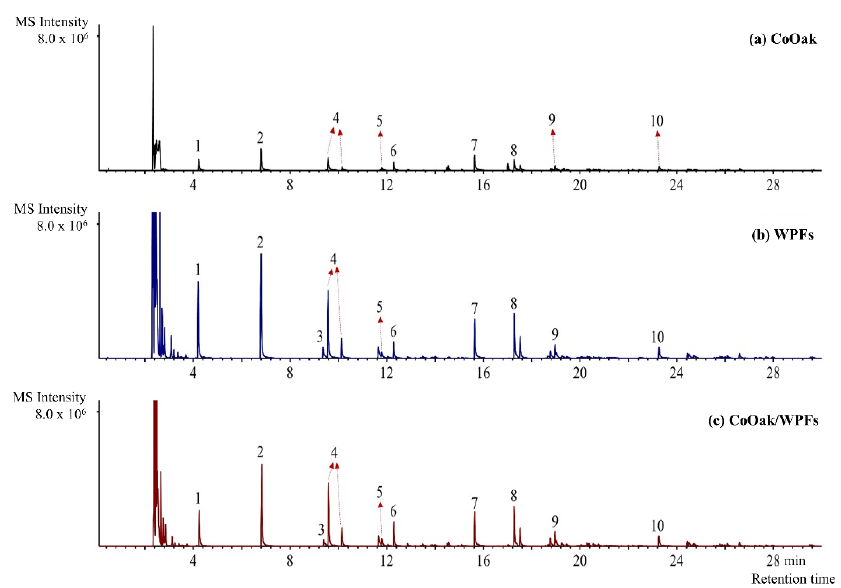
Figure 3. Pyrograms obtained from catalytic pyrolysis of ( a ) Cork Oak; ( b ) WPFS; and ( c ) Cork Oak/WPFS over HBeta(25). (1: benzene, 2: toluene, 3: ethylbenzene, 4: xylenes, 5: ethyltoluene, 6: trimethylbenzene, 7: naphthalene, 8: methylnaphthalene, 9: anthracene, 10: pyrene).